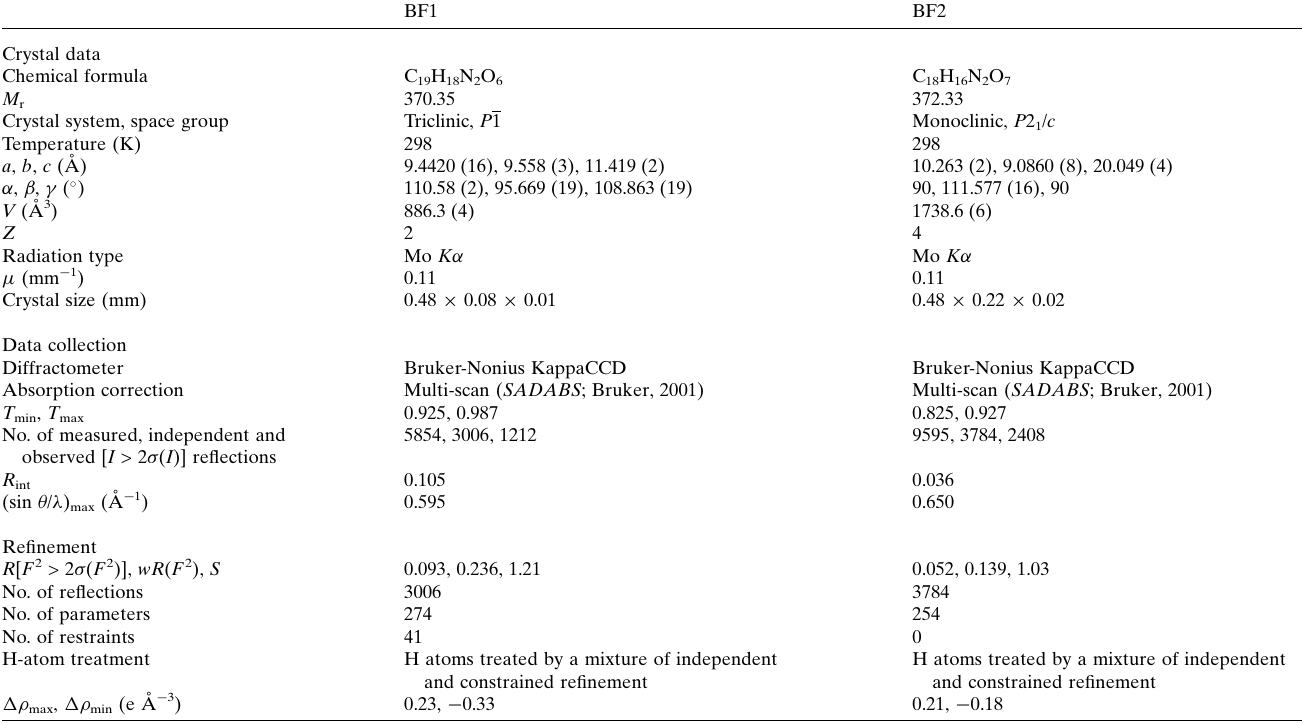
Table 5 Experimental details.